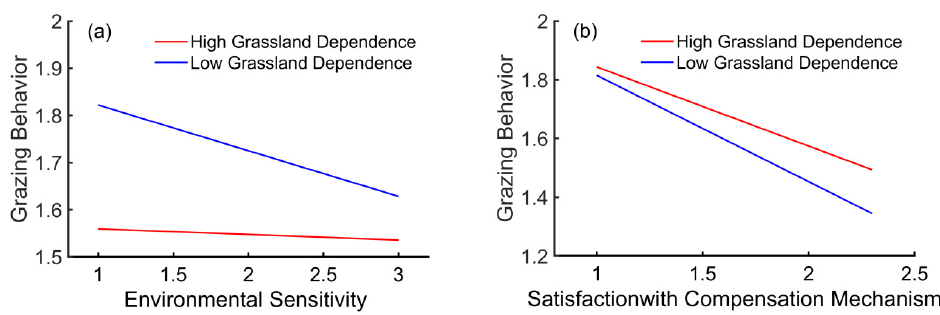
Figure 4. ( a ) Interaction effects of grassland dependence and environmental sensitivity; ( b ) Interaction effects of grassland dependence and satisfaction with compensation mechanism.